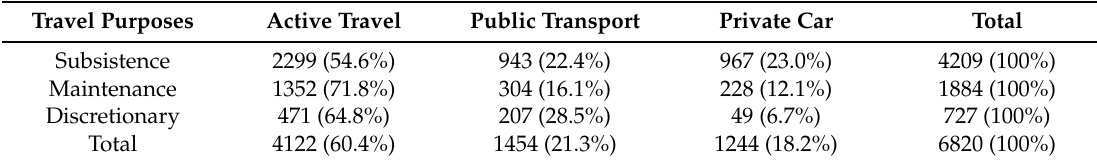
Table 3. Mode choice for different travel